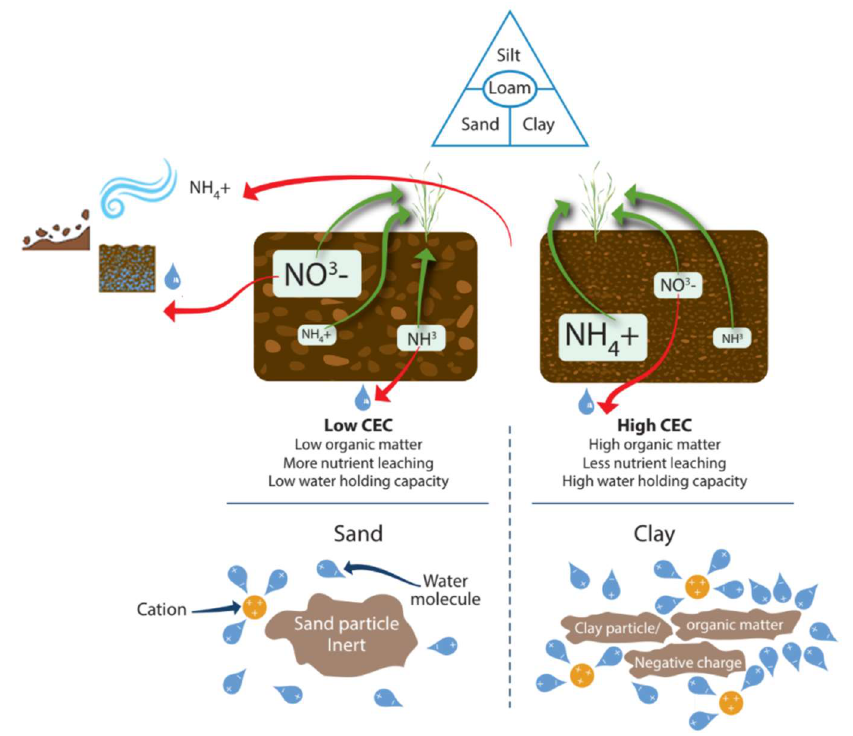
Figure 9. Factors controlling leaching, runoff, and erosion loss pathway from the soil-plant system. Icons show: wind, slope and wet ground, and water bonding to cation charge.